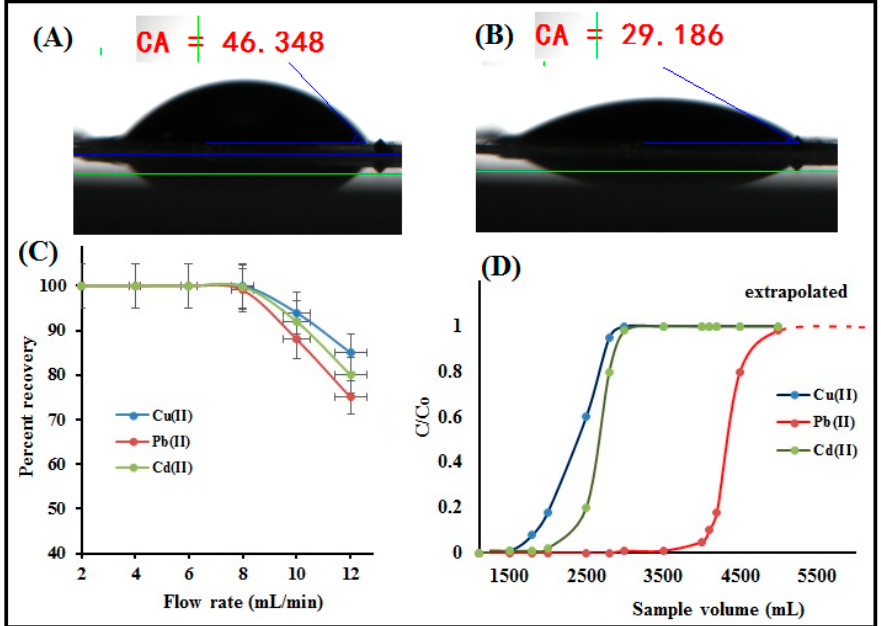
Figure 7. Water contact angle measurement of; ( A ) nascent cellulose nanofibers and ( B ) APBC nanofibers, ( C ) effect of column flow rate and ( D ) breakthrough curve for the extraction of Cu(II0, Pb(II) and Cd(II) (experimental conditions: sorbent amount 25.0 mg; pH = 6.0; flow rate = 8 mL min − 1 , M n+ = 10 mg L − 1